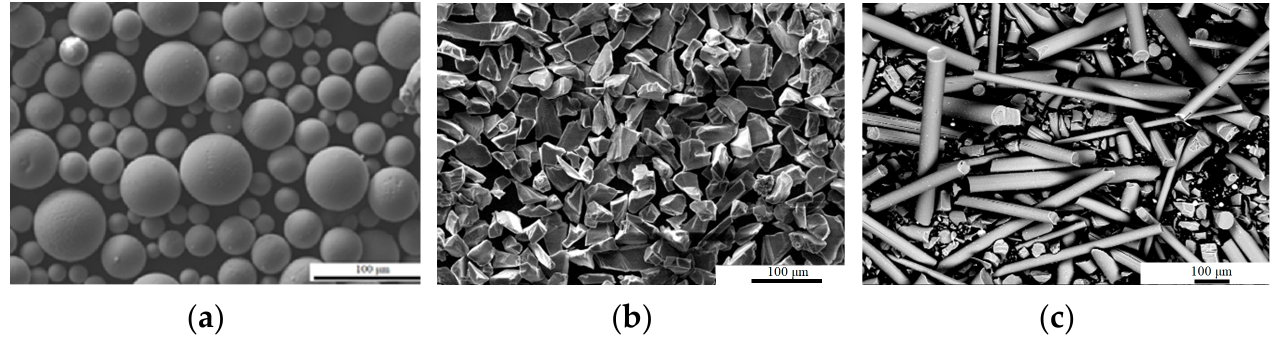
Figure 1. SEM image of the used powders (( a )-Ti64, ( b )-SiC ceramic particles, ( c )-SiC ceramic fibers). For creating a ceramic-metal heterogeneous material by laser surface cladding (LSC) and direct laser deposition (DMD), an IPG Photonics ytterbium fiber laser with a wave- length of 1.07 µ m and a maximum power of 3 kW was used. Figure 2 is a schematic representation of the used laser